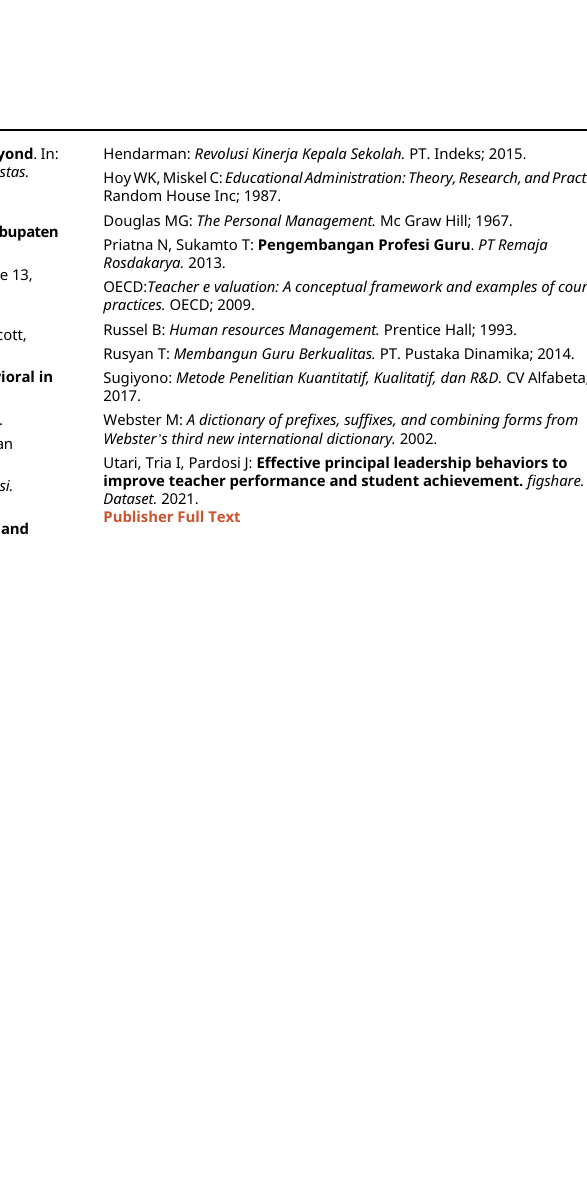
Figshare. Effective principal leadership behaviors to improve teacher performance and student achievement.